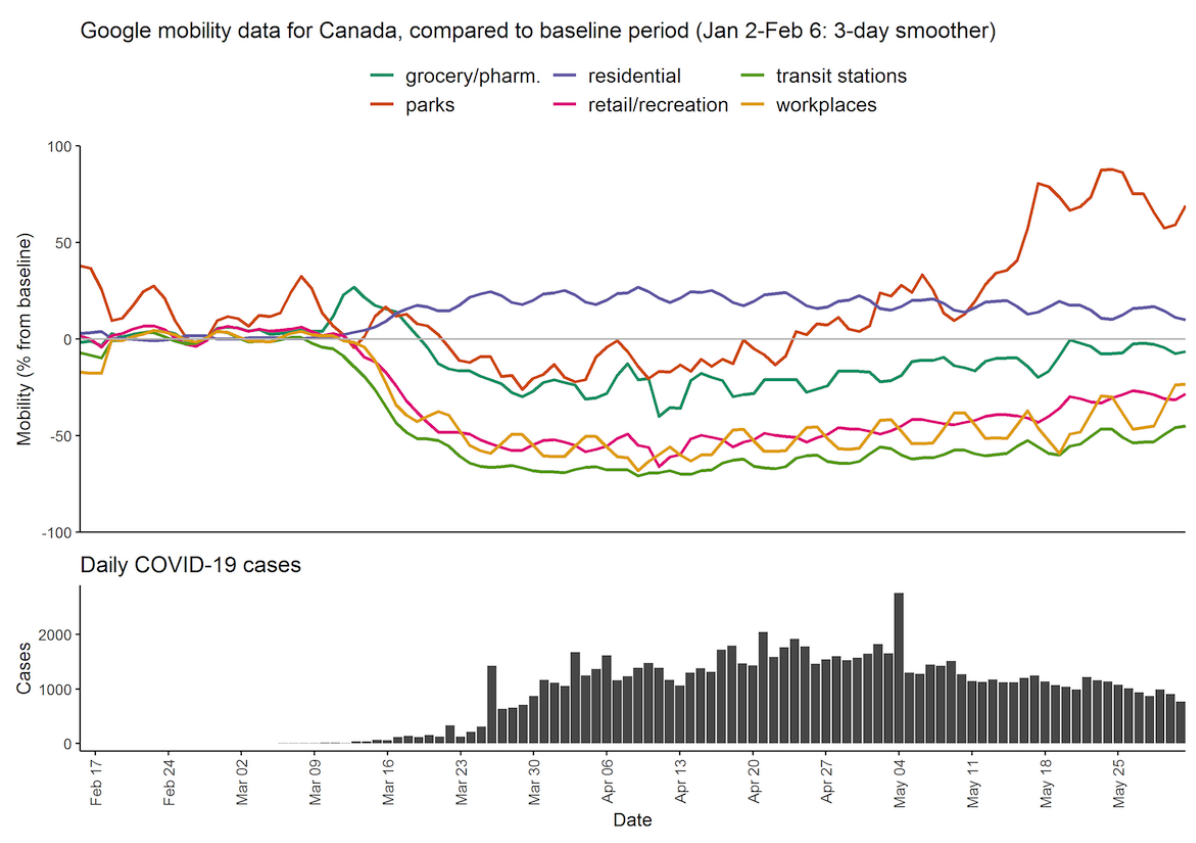
Figure 1. Mobility and case count for Canada from February 15 to May 31, 2020. Google mobility data is only available since February 15. pharm.: